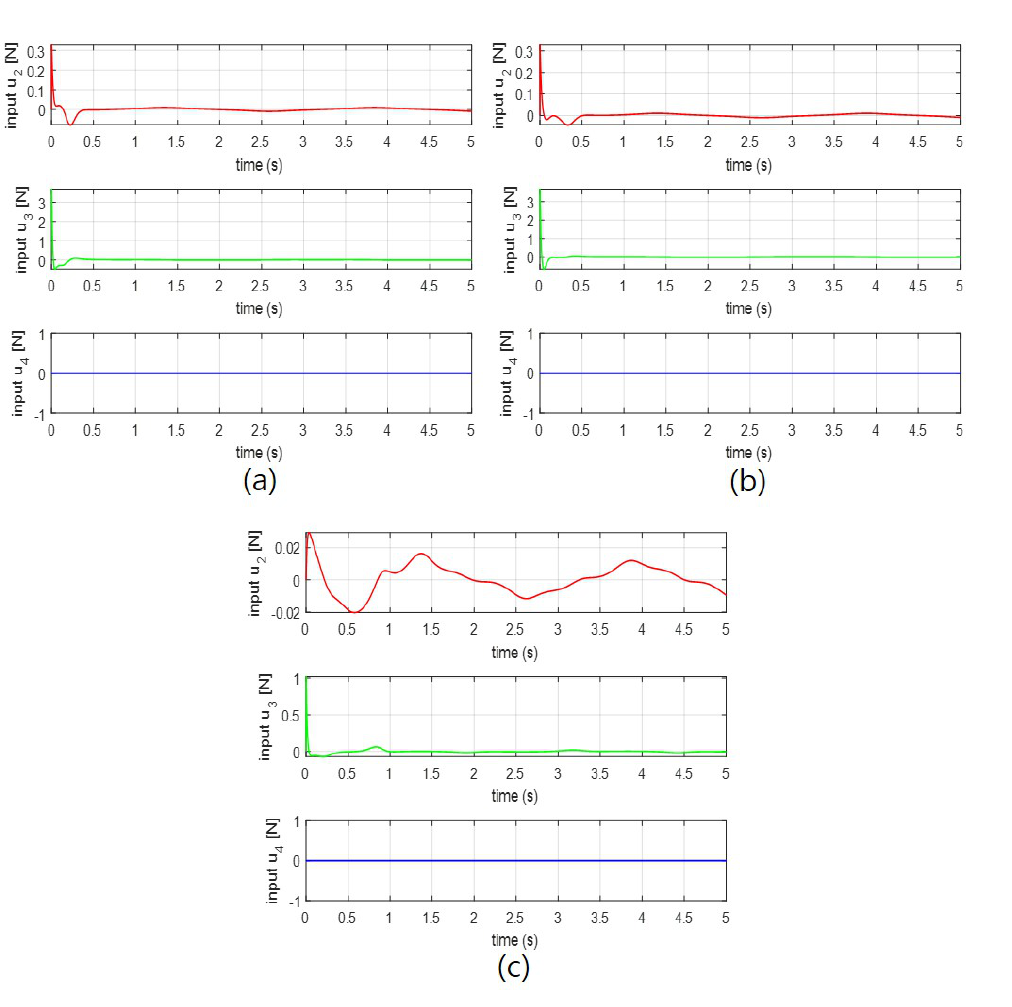
Figure 14. The control inputs for the attitude of a quadrotor: ( a ) Inverse optimal control; ( b ) LQR control; ( c ) PD control.